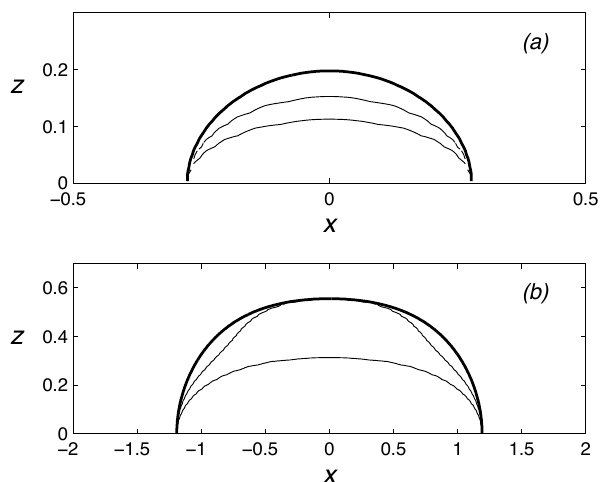
Fig. 4. The region in the core of the extended- ¯ s DJL solutions in (a) Fig. 2 and (b) Fig. 3 where 0 ≤ Ri ≤ 0 . 25. The heavy solid line shows the core boundary ( s = 1) and the thin lines show Ri =0 (lower line) and Ri =0.25 (upper line)